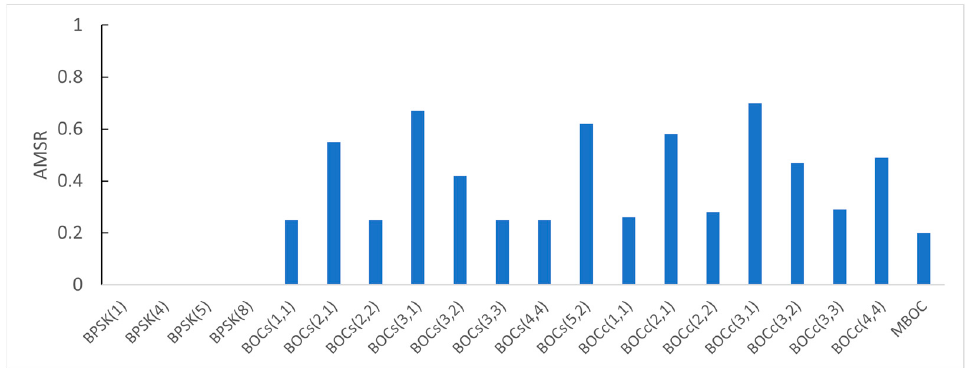
Figure 11. The AMSR for each candidate.